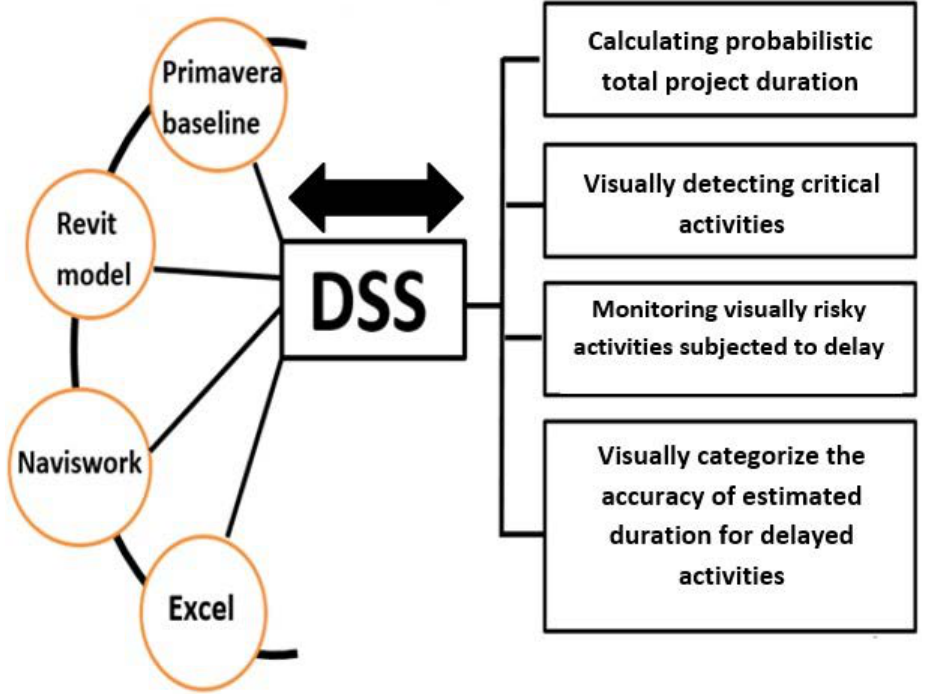
Figure 3. Research